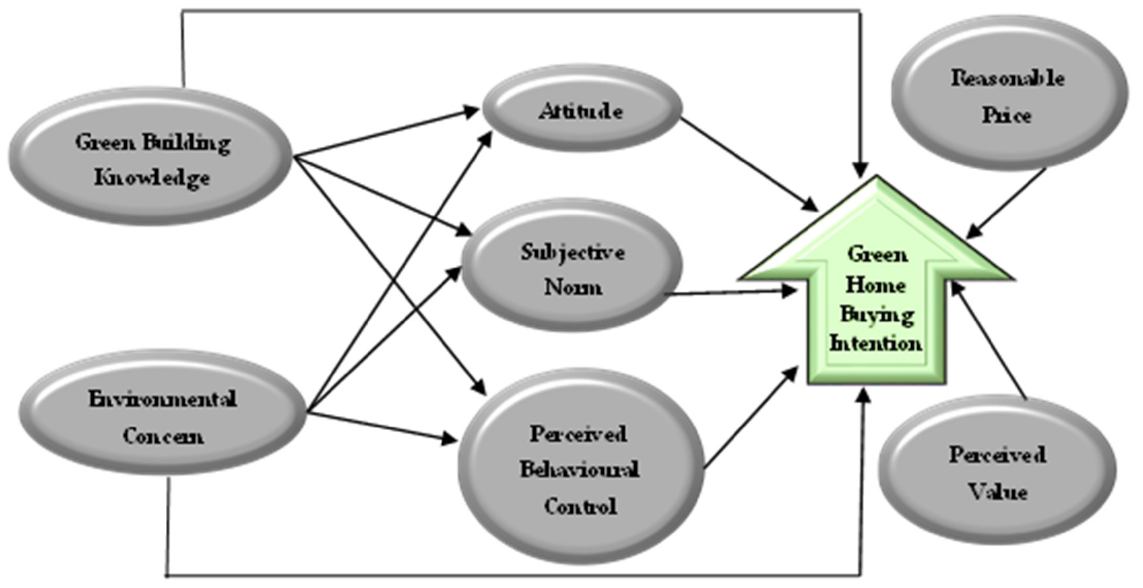
Figure 1. Proposed research framework.